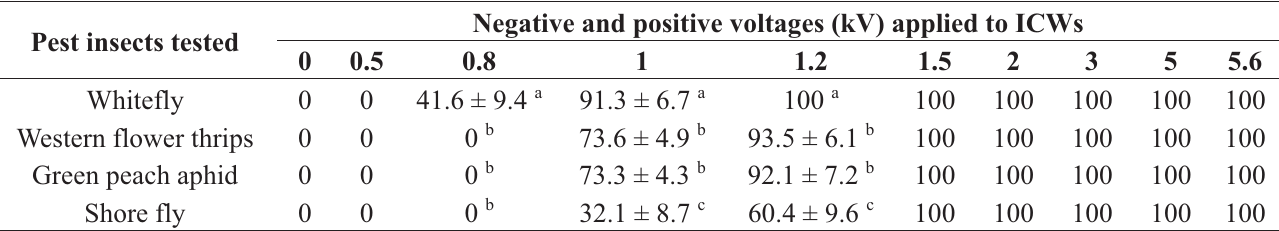
Table 1. Percentage of pest insects captured by ICWs of an electrostatic insect sweeper. Seven to ten adults were used for each voltage and for each insect species, and the means and standard deviations of five replicates were calculated. Different letters (a – c) on each vertical column indicate significant differences ( p < 0.05) according to Tukey’s